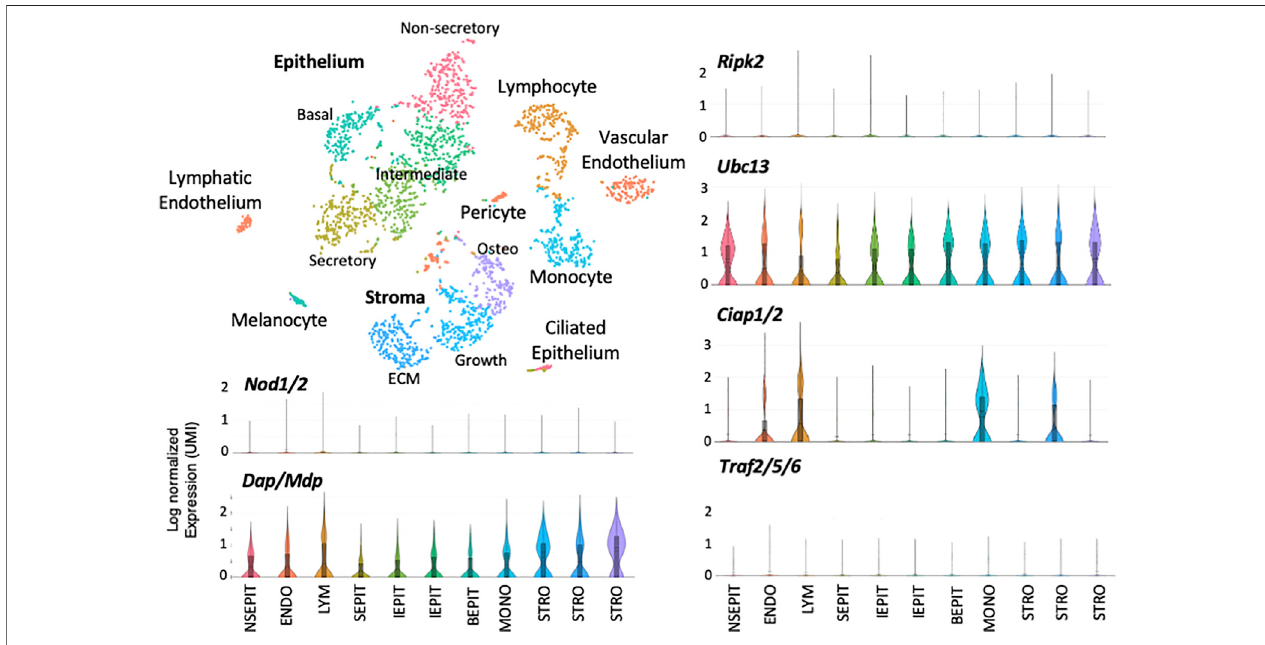
FIGURE 3 | Single-cell RNA-Seq data from the uninfected ME. Single-cell transcriptomes were generated from cells of the normal ME and subjected to PCA to generate clusters based on differential gene expression. Marker genes were used to identify the cell types present in each cluster. Some cell types were divided by PCA into multiple clusters (e.g., epithelial and stromal cells, while others were combined into a single cluster (vascular and lymphatic endothelial cells with pericytes). Expressionofgenesandgenecombinationsarepresented asviolinplots,inwhichtheverticallinerepresents thehighestexpressingcell,whilethewidthoftheplot representsthe number ofcells at that normalized logexpression level. Notably, the Nod and Ripk2 geneswereexpressed byveryfew cellsofany type in thenormal ME.